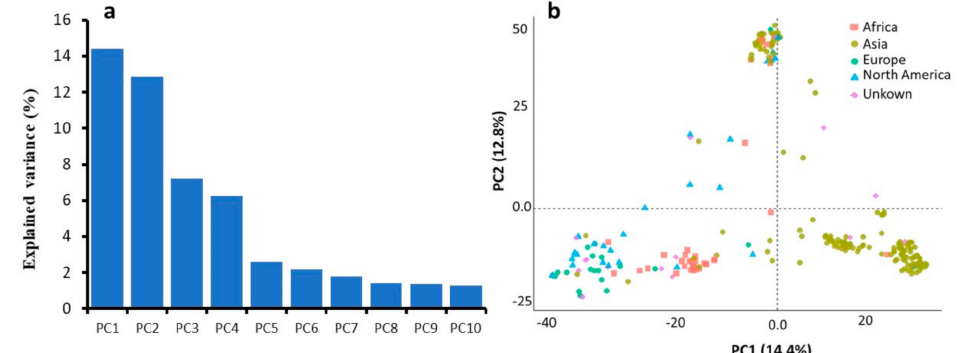
Figure 3. Plots for the principal components (PCs). ( a ) The scree plot shows the variance explained by the first 10 PCs. ( b ) The distribution of the 254 intermedium -spike barley lines in PC1 vs. PC2 (‘continents’ used as covariate).